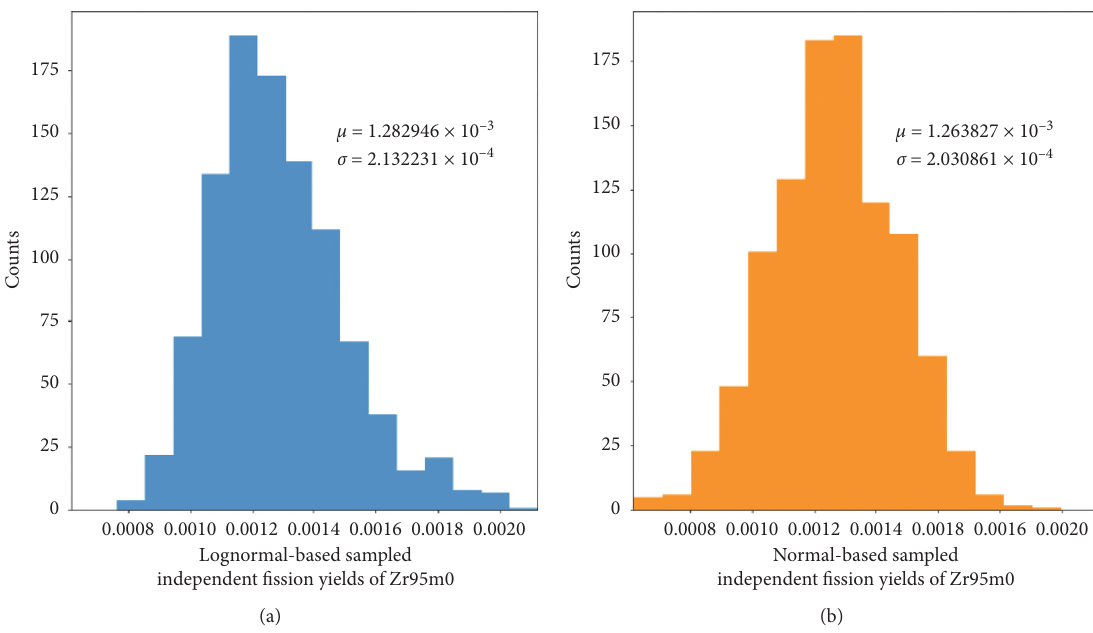
Figure 14: Histogram comparison of lognormal sampled (a) and normal sampled (b) independent fission yields of Zr95m0. This fission product has relative uncertainty of 16.1%. The text presents the sampled mean value and STD and the population mean and STD for Zr95m0 are 1 . 271856 × 10 − 3 and 2 . 029263 × 10 − 4 .